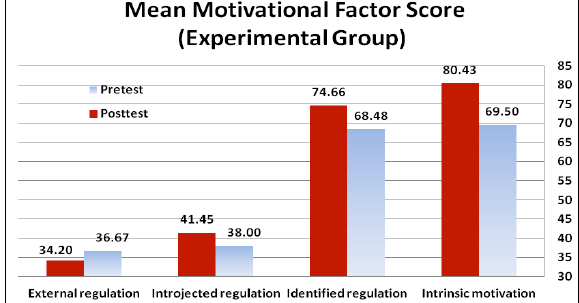
Figure 1. Mean motivational factor score among experimental group members